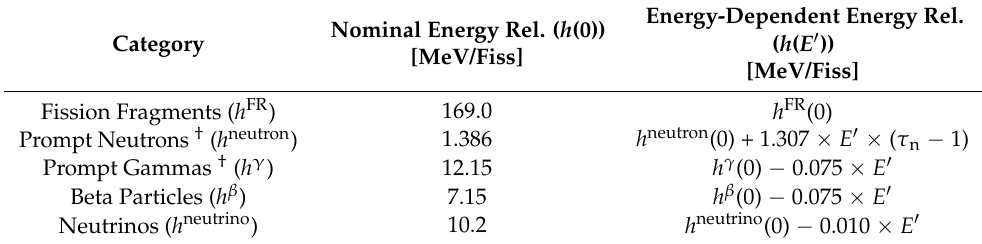
Table 1. Fission energy release by category for fictitious, purely-fissioning fuel nuclide. Energy-Dependent Energy Rel. Nominal Energy Rel. ( h (0)) Category ( h ( E (cid:48) )) [MeV/Fiss] [MeV/Fiss] Fission Fragments ( h FR )